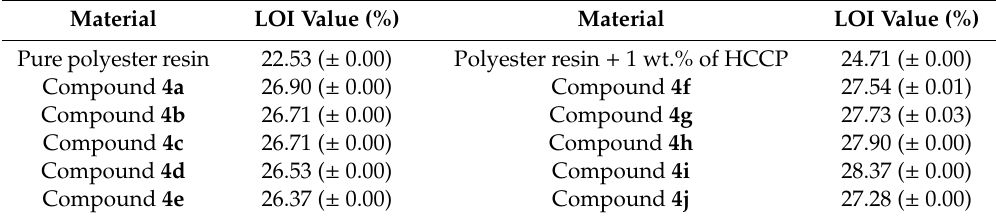
Table 4. LOI test